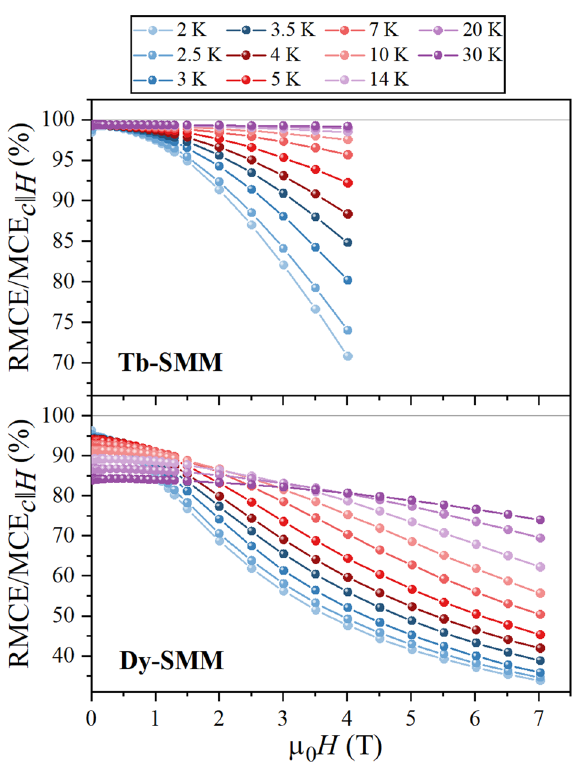
Figure 9. The ratio RMCE/MCE c ∥ H between RMCE and conventional MCE measured for c ∥ H at T = 2–80 K for Tb-SMM in magnetic fields up to µ 0 H = 4 T and Dy-SMM in fields up to µ 0 H = 7 T. Solid lines are guides for the